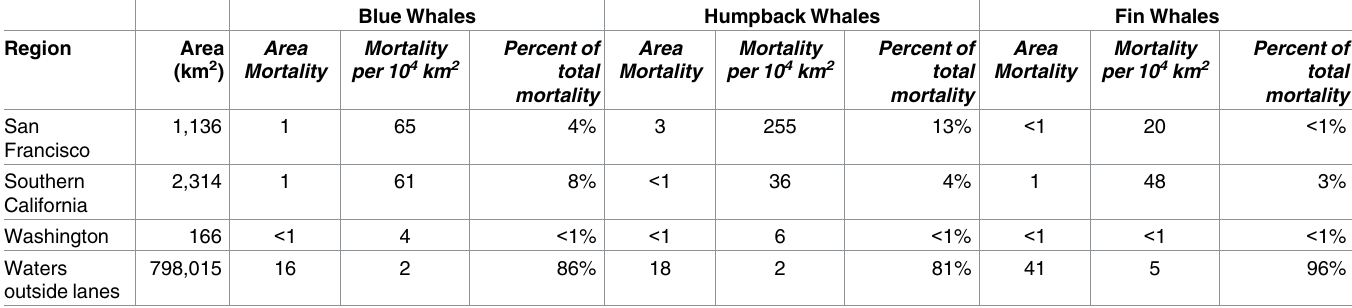
Table 6. Mortality statistics for shipping lanes. Mortality per 100,000km 2 and percent of total study area mortality are also reportedfor each region. Blue Whales Humpback Whales Fin